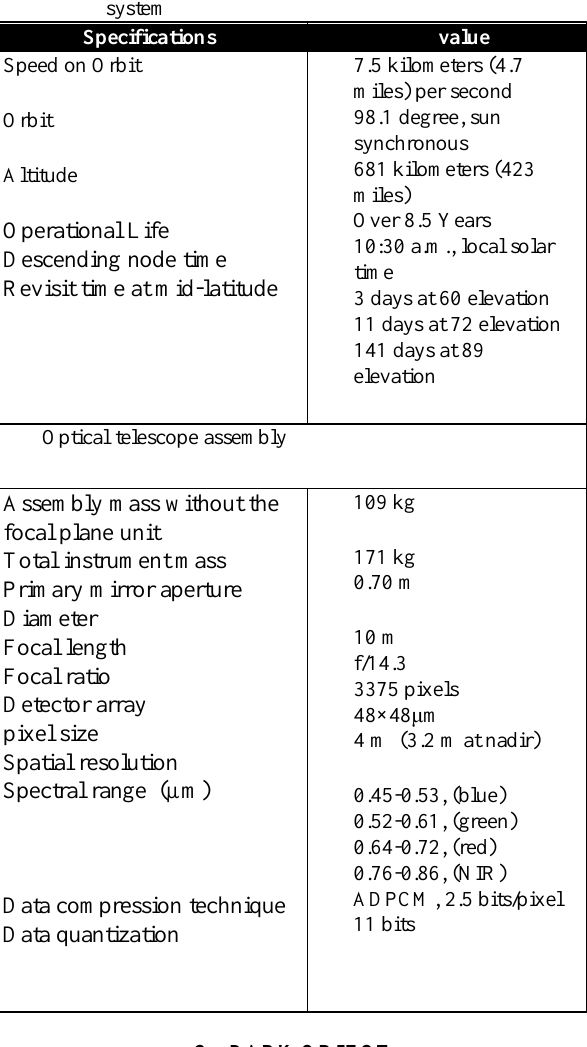
Table 1 Specifications of IKONOS satellite and MS imaging